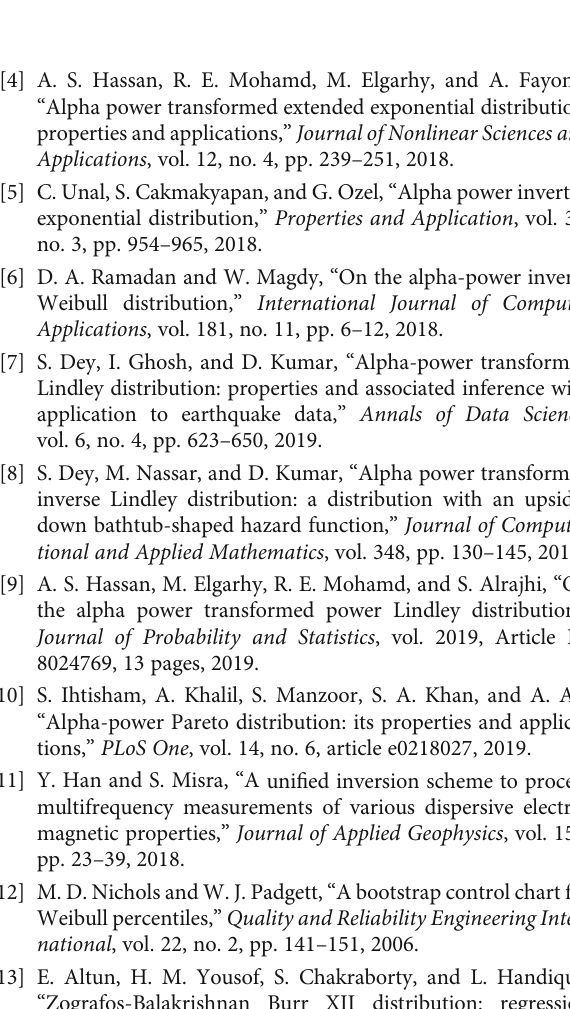
Figure 3: Plots of estimated pdf, cdf, sf, and pp for breaking stress